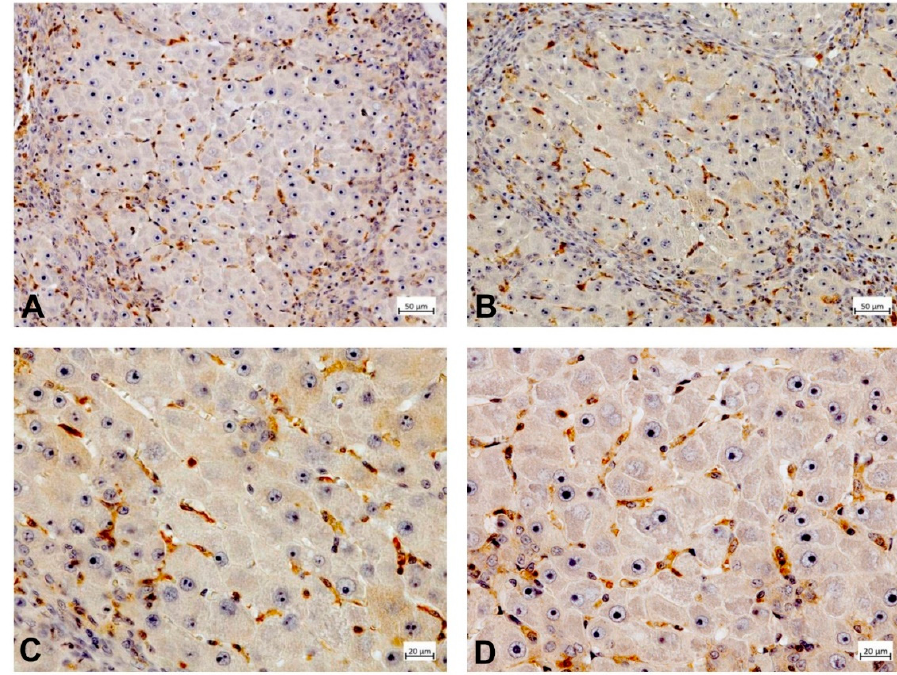
Figure 3. PDE-5 expression in cirrhotic rat liver tissue (thioacetamide (TAA)-model). Mesenchymal cells present in interconnecting fibrous septa ( A , B ) and sinusoidal lining cells of parenchymal islands ( A – D ) are immunolabeled by PDE-5 antibody. The architectural disturbance of liver parenchyma is associated with marked PDE-5 immunoreactivity of sinusoidal lining cells throughout the nodules ( C , D ).